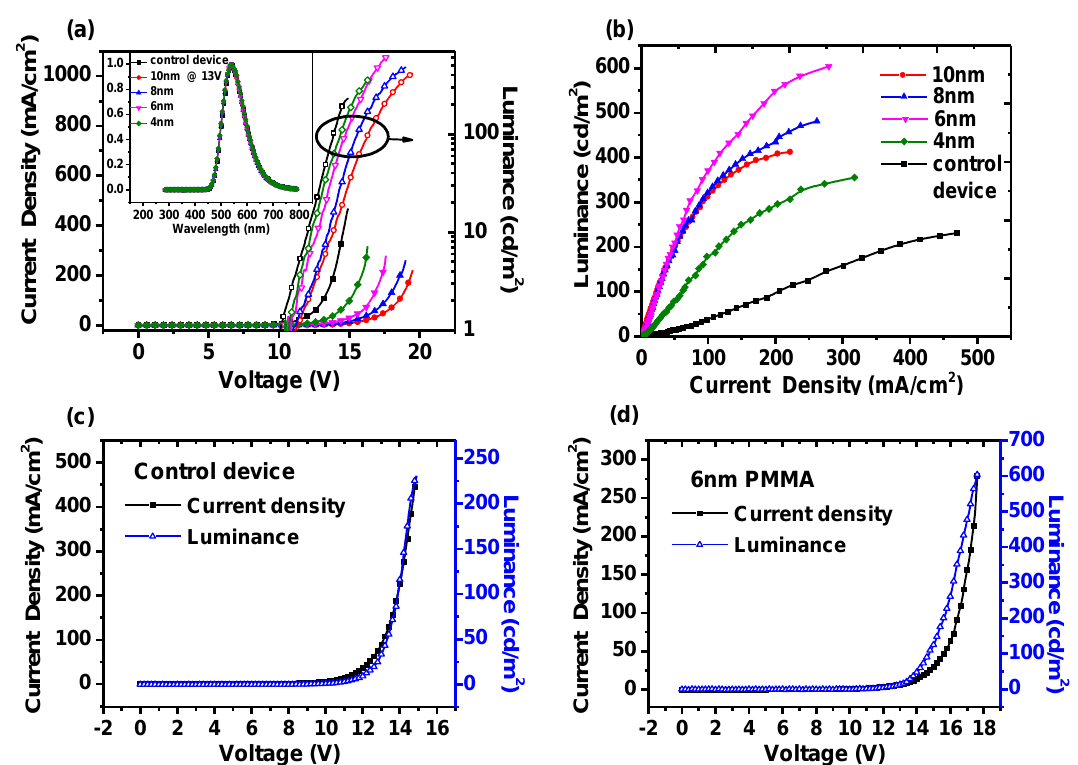
Figure 2. ( a ) J-V-L characteristics of all devices, inset is EL spectra of all devices operating under 13 V ( b ) L-J characteristics of all devices ( c ) J-V-L characteristics for control device ( d ) J-V-L characteristics for a device with 6 nm PMMA layer.